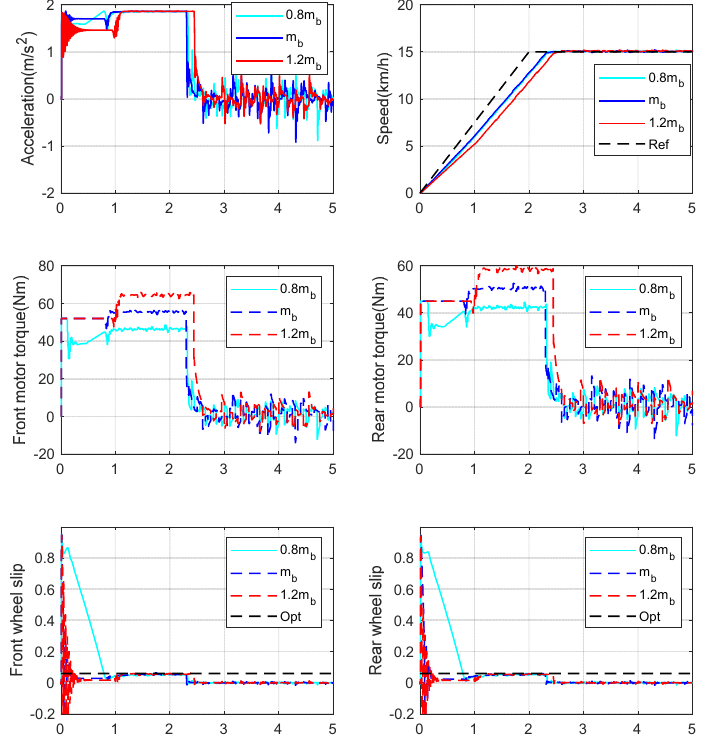
Figure 14. The robustness verification.